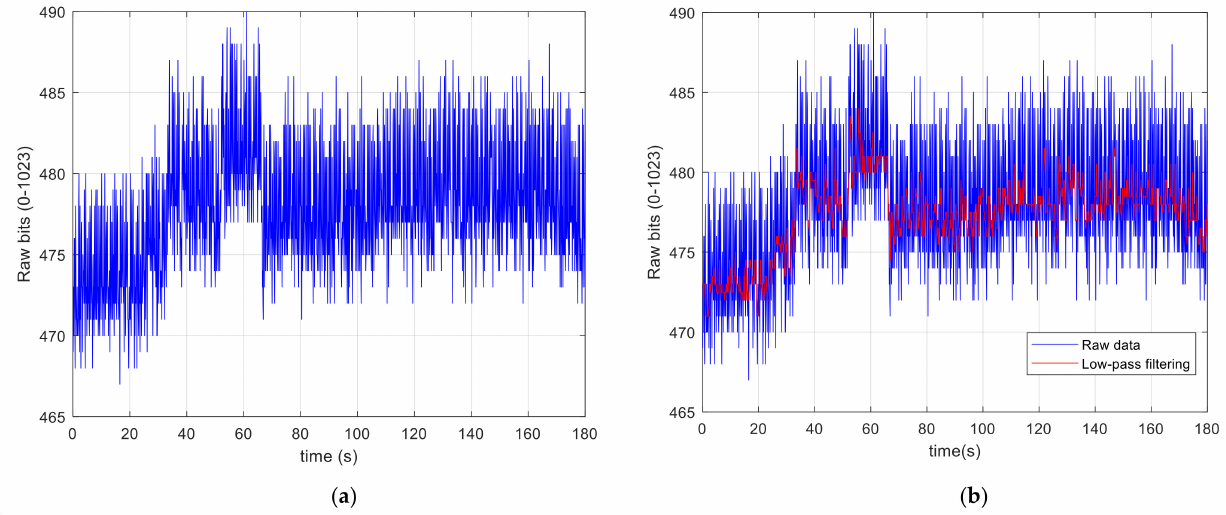
Figure 9. ( a ) Raw data from the MPX2010DP, with v w = 0. ( b ) Comparison between the raw data and the low-pass-filtered